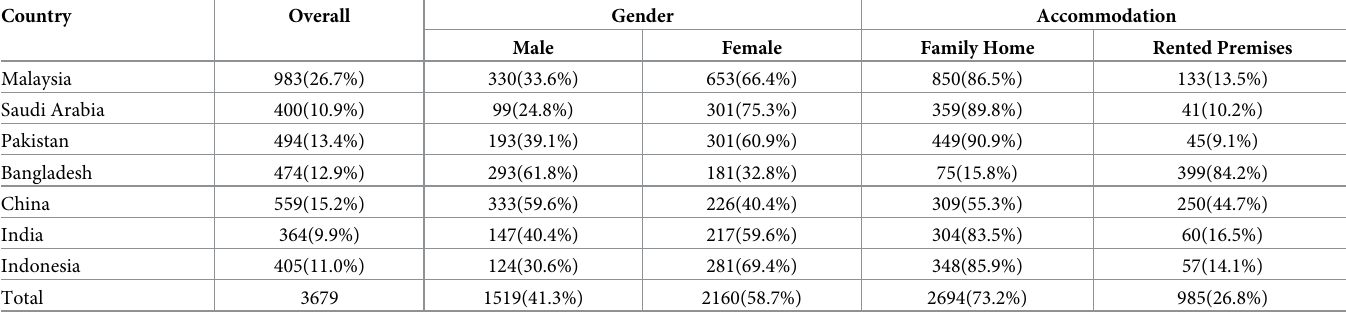
Table 1. Distribution of respondents in this study.